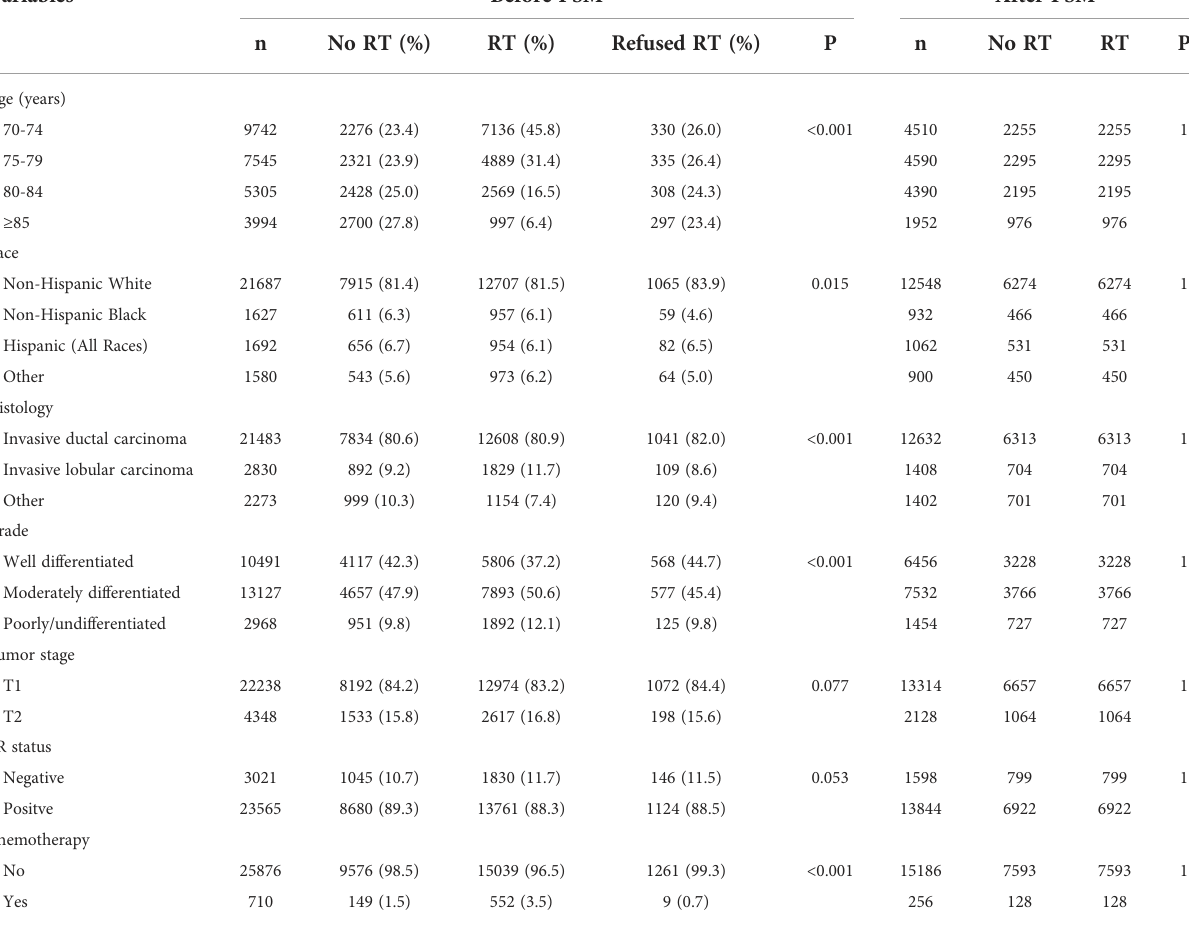
TABLE 1 Patients ’ baseline characteristics before and after propensity score matching.